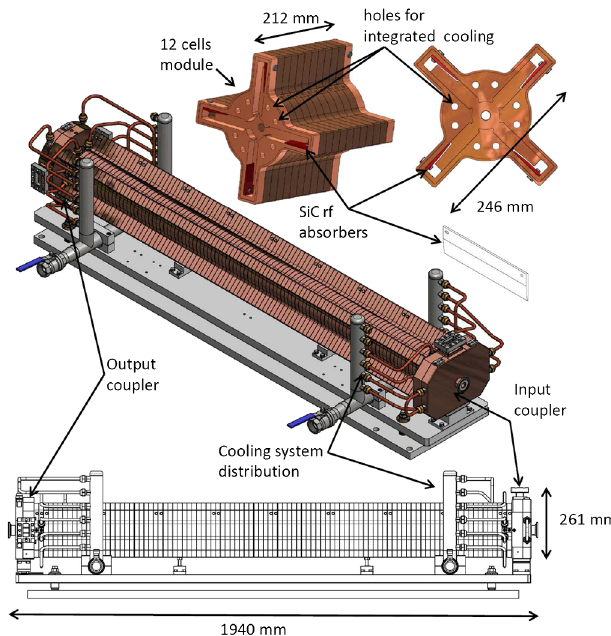
FIG. 2. Mechanical drawings of the C -band structures.